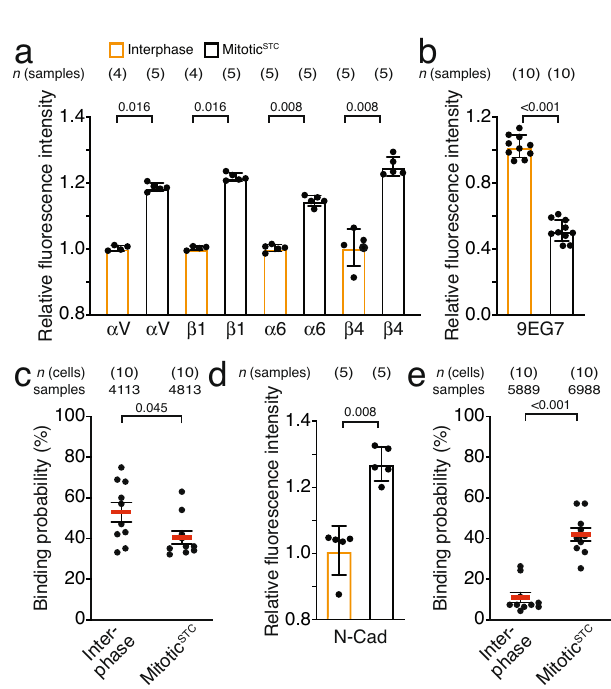
Fig.2|Ligandbindingofintegrinandcadherinisregulatedthroughoutthecell cycle.a Interphaseandmitotic STC HeLacellswere fl uorescentlylabeledforintegrin subunits α V, β 1, α 6 and β 4 and analyzed by fl ow cytometry. Dots represent the median fl uorescent intensities of 20,000 cells analyzed per sample normalized to the meanofmedian fl uorescent intensity of interphase HeLacellsamples, bars the mean of allmedians and error bars show the SEM. n (samples) indicate the number of biological independent samples tested. b Flow cytometry of interphase and mitotic STC HeLa cells labeled for β 1 integrins in an extended conformation (clone 9EG7). Data representation as described for a . c Binding probability of interphase and mitotic STC HeLa cells to Matrigel. Dots represent the binding probability of individualHeLacells, red bars indicate the medianbindingprobability of all tested cells,andtheerrorbarstheSEM. n (cells)indicatesthenumberofHeLacellsprobed and samples the number of force-distance recorded for each condition. d Interphaseandmitotic STC HeLacellswerelabeledforN-cadherinsandanalyzedby fl ow cytometry. Data representation as described in a . e Binding probability of interphase or mitotic STC HeLa cells to single interphase cells spread on the sub- strate.Datarepresentationasdescribedin c . P valuescompareindicatedconditions and were calculated using two-tailed Mann – Whitney